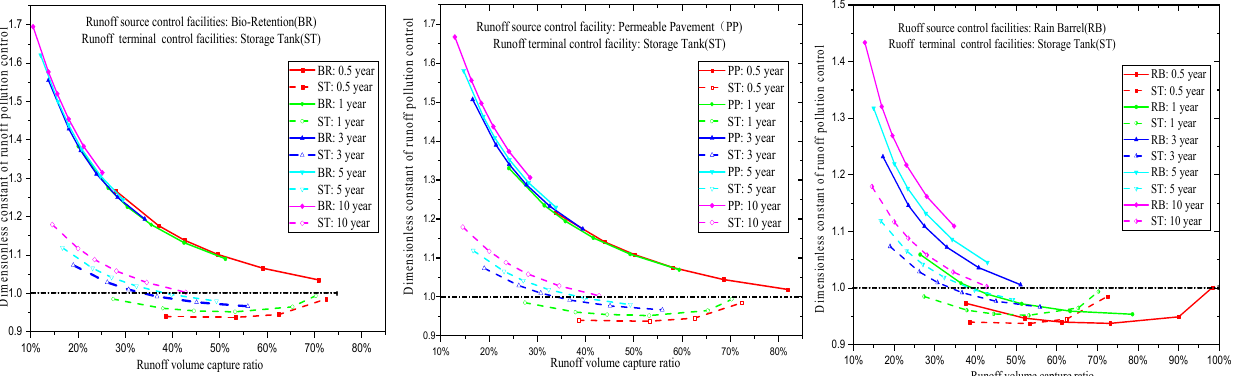
Figure 6. Variation curve of Dc value of source facilities and terminal facilities under different vol- ume control rates. control